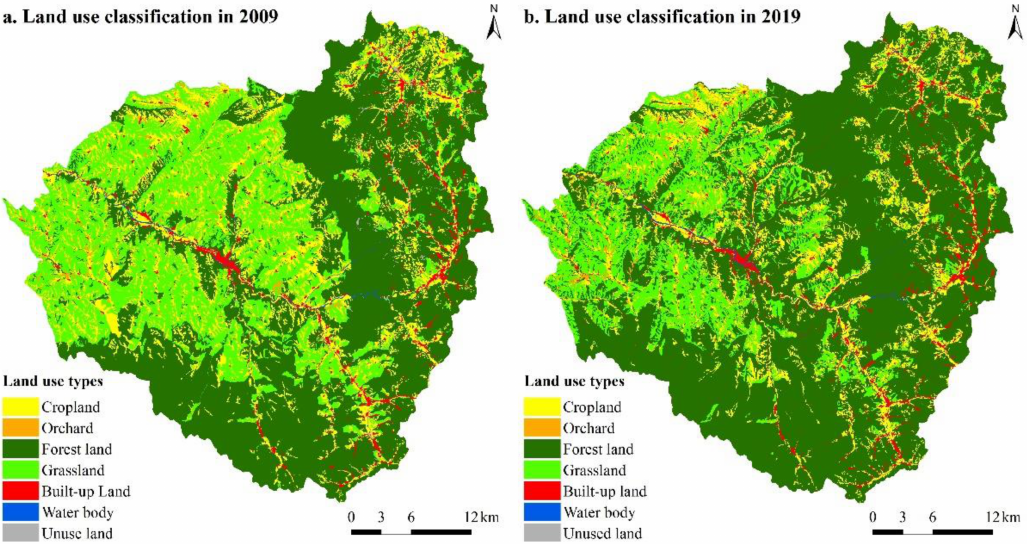
Figure 5. Land use classification in Pu County over the past